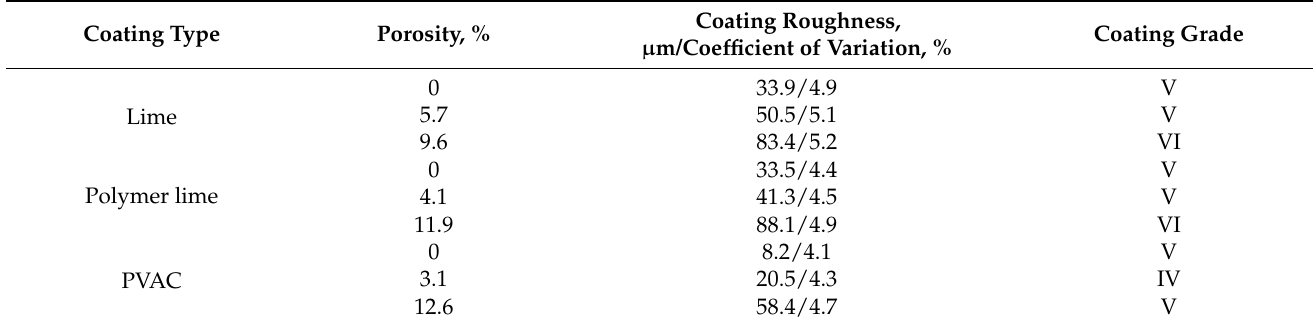
Table 5. Effect of substrate porosity on the appearance quality of coatings.